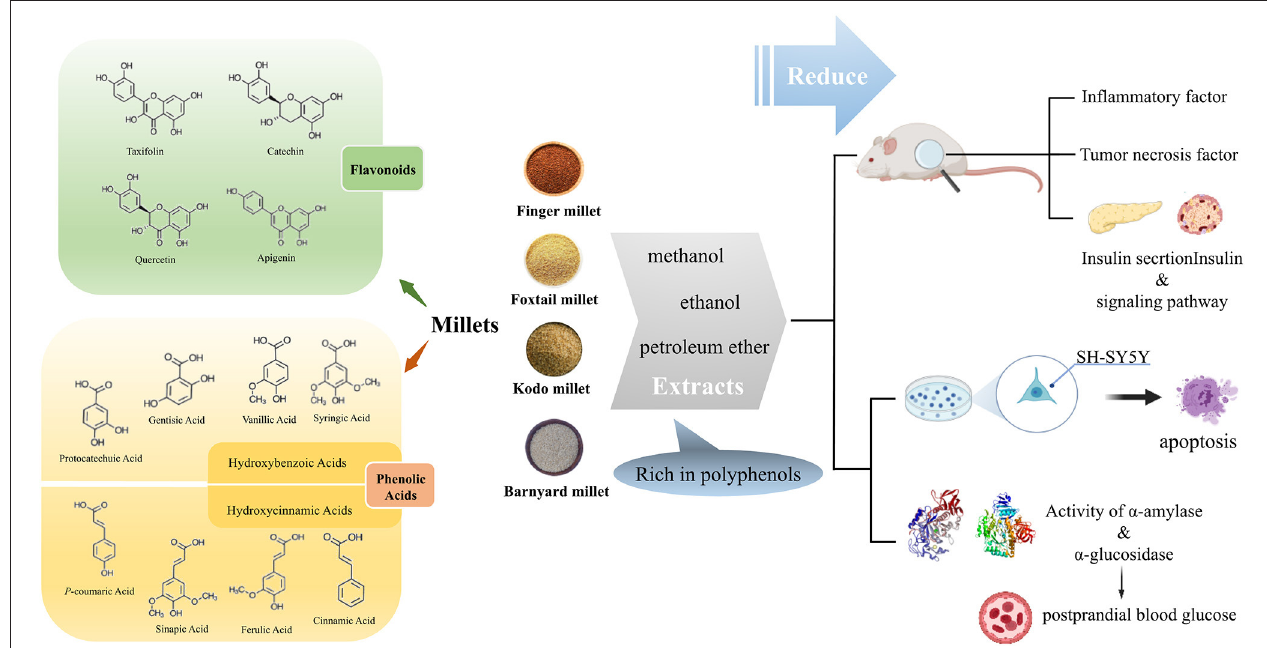
FIGURE 1 | Polyphenols in millets and their effect on diabetes related factors. The polyphenols in millet mainly include phenolic acids and flavonoids. Through the summary of in vivo and in vitro experiments on the effects of millet polyphenols on diabetes, we found that the polyphenol extracts of millet affected antioxidant and anti-inflammatory factors, the insulin signal pathway, and enzyme activities related to postprandial blood glucose. This figure was partly created with BioRender.com, and the agreement number is